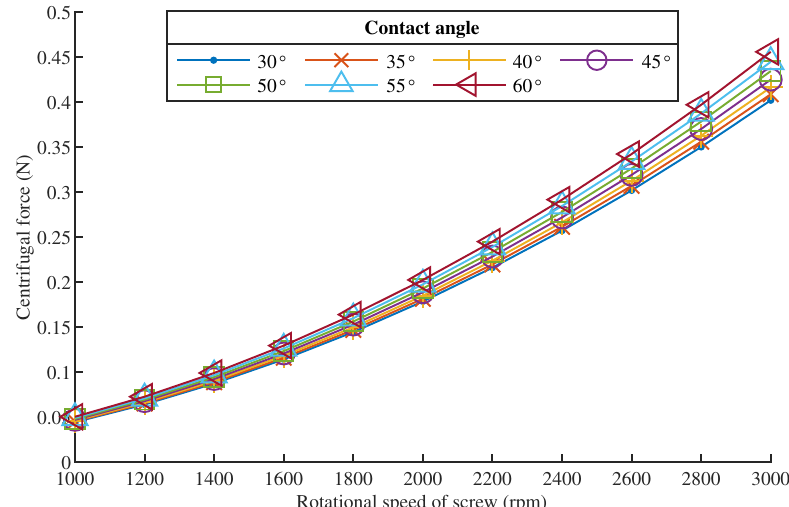
Figure 4. Centrifugal force when rotational speed and contact angle varies.